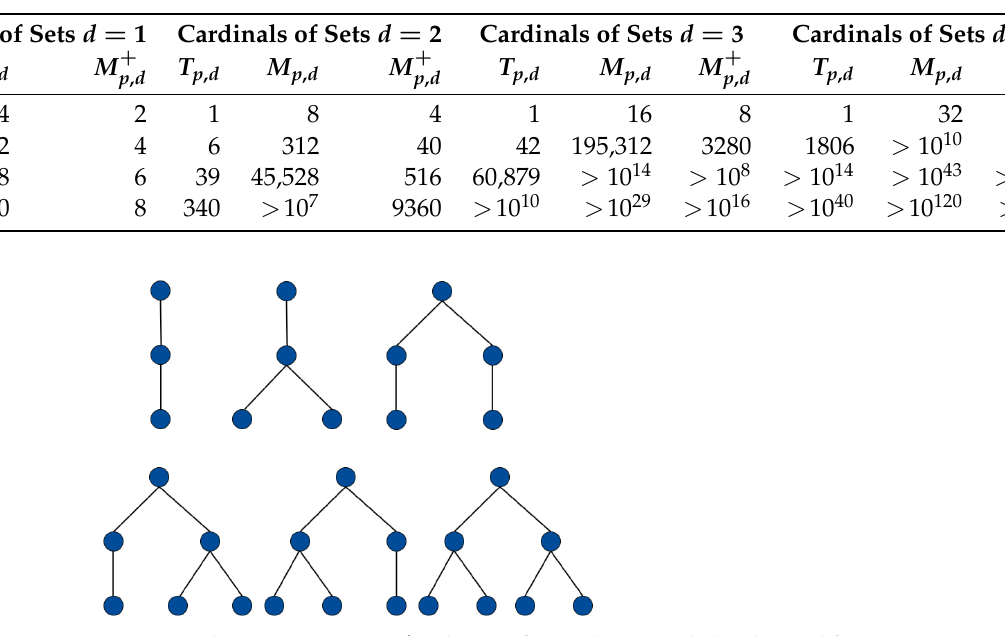
), for different d and p . p , d